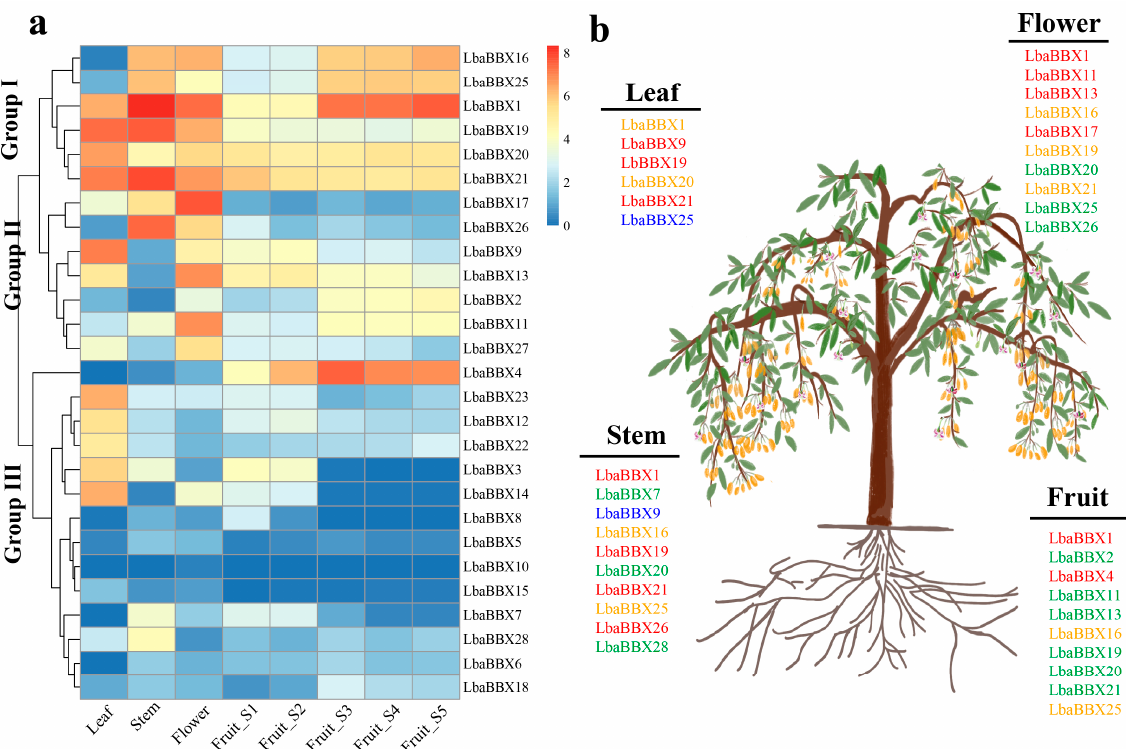
Figure 6. Expression pattern of LbaBBX genes. ( a ) Tissue-specific expression pattern of LbaBBX genes in four tissues: leaf, stem, flower, and fruits, including five development stages. Blue and red color indicated lower and higher transcript abundance, respectively. ( b ) Identification of highly expressed BBX genes in L. barbarum . Blue, green, orange, red indicated low (1–7.3 FPKM), mid-low (7.3–48 FPKM), mid-high (48–114 FPKM), and high (114–317 FPKM) expression, respectively.